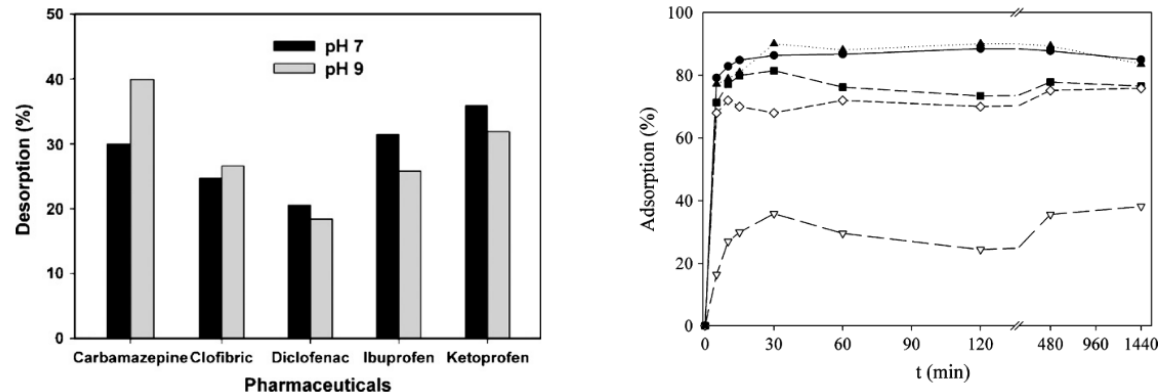
Figure 8. Desorption of pharmaceuticals after 2 h sorption step on SBA-15 (in 1 mM phosphate buffer, pH 7 and 9, ionic strength 0.01 M KCl, 25 °C, reaction time 12 h) adapted with permission from [115].